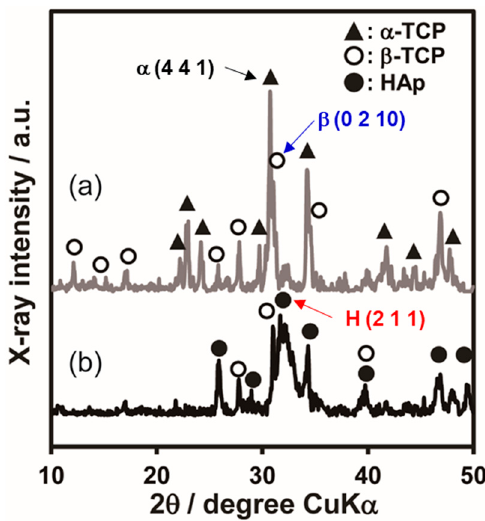
Figure 3. Phase analysis of Ag-TCP(5) powder and cement. XRD patterns of ( a ) Ag-TCP powder and ( b ) Ag-TCP cement.